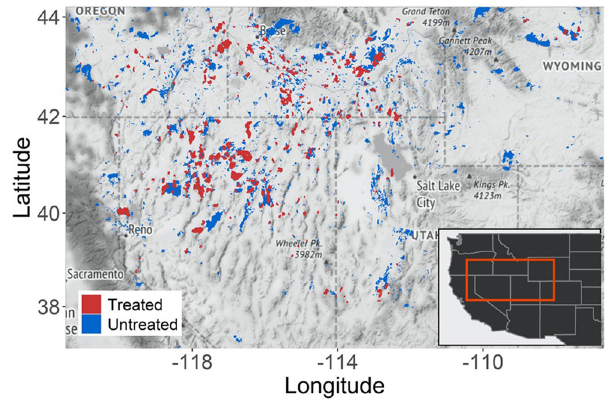
Fig. 1 Study area description. Burned areas that received Artemisia seeding treatments (as recorded by the Land Treatment Digital Library) and or remained untreated following fi res occurring between 1986 and 2001 in the western United States. Areas that burned twice during this period were excluded from the analysis (Map data